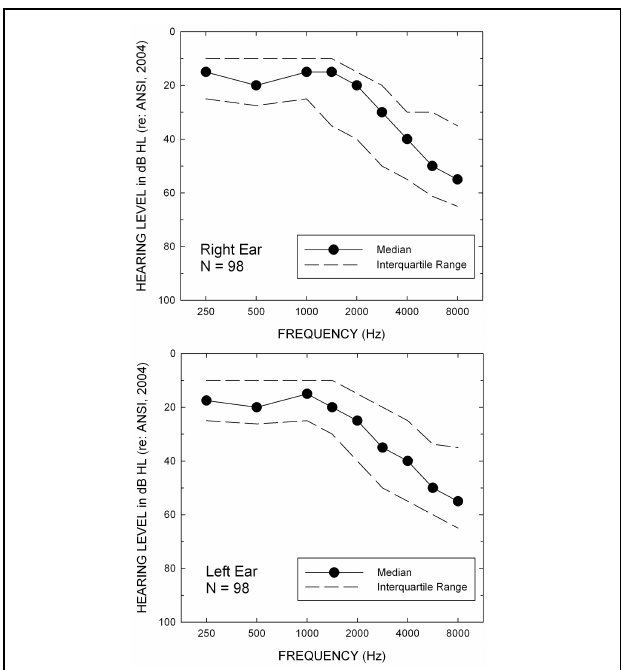
FIGURE 1 | Median hearing thresholds (filled circles) and interquartile ranges for the right (top) and left (bottom) ears of the 98 older adults in this